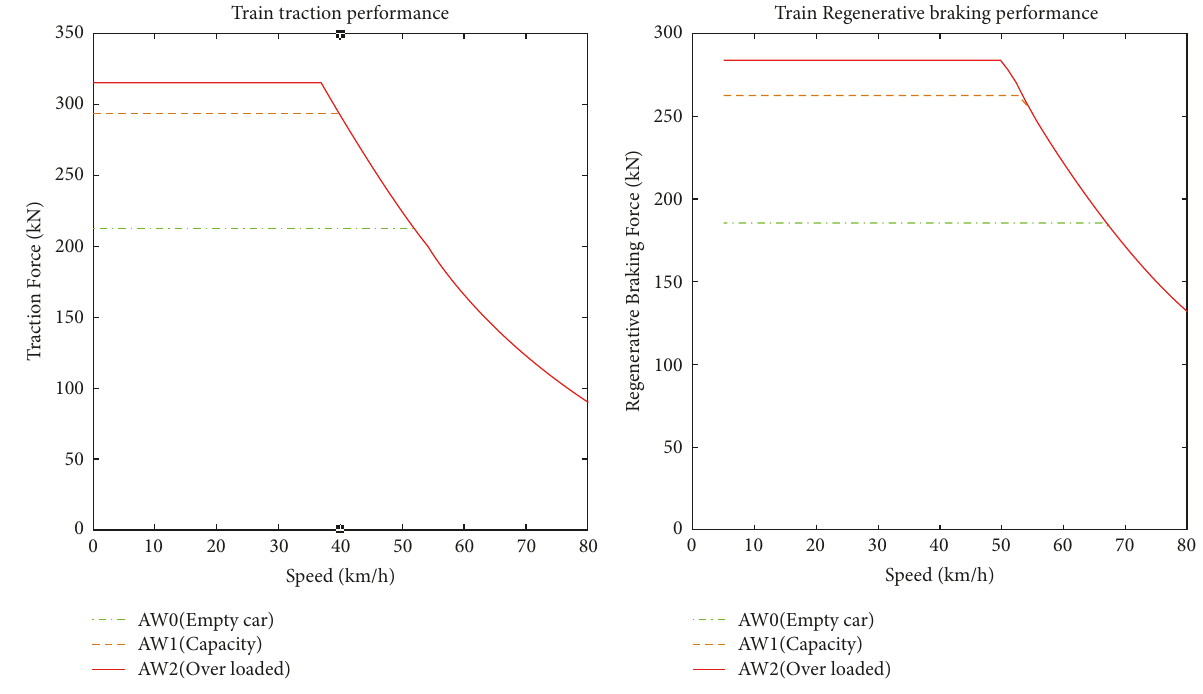
Figure 11: The power performance under different load factors.